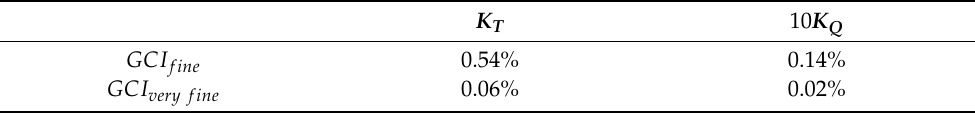
Table 4. Numerical uncertainty analyses from grid convergence at J A =